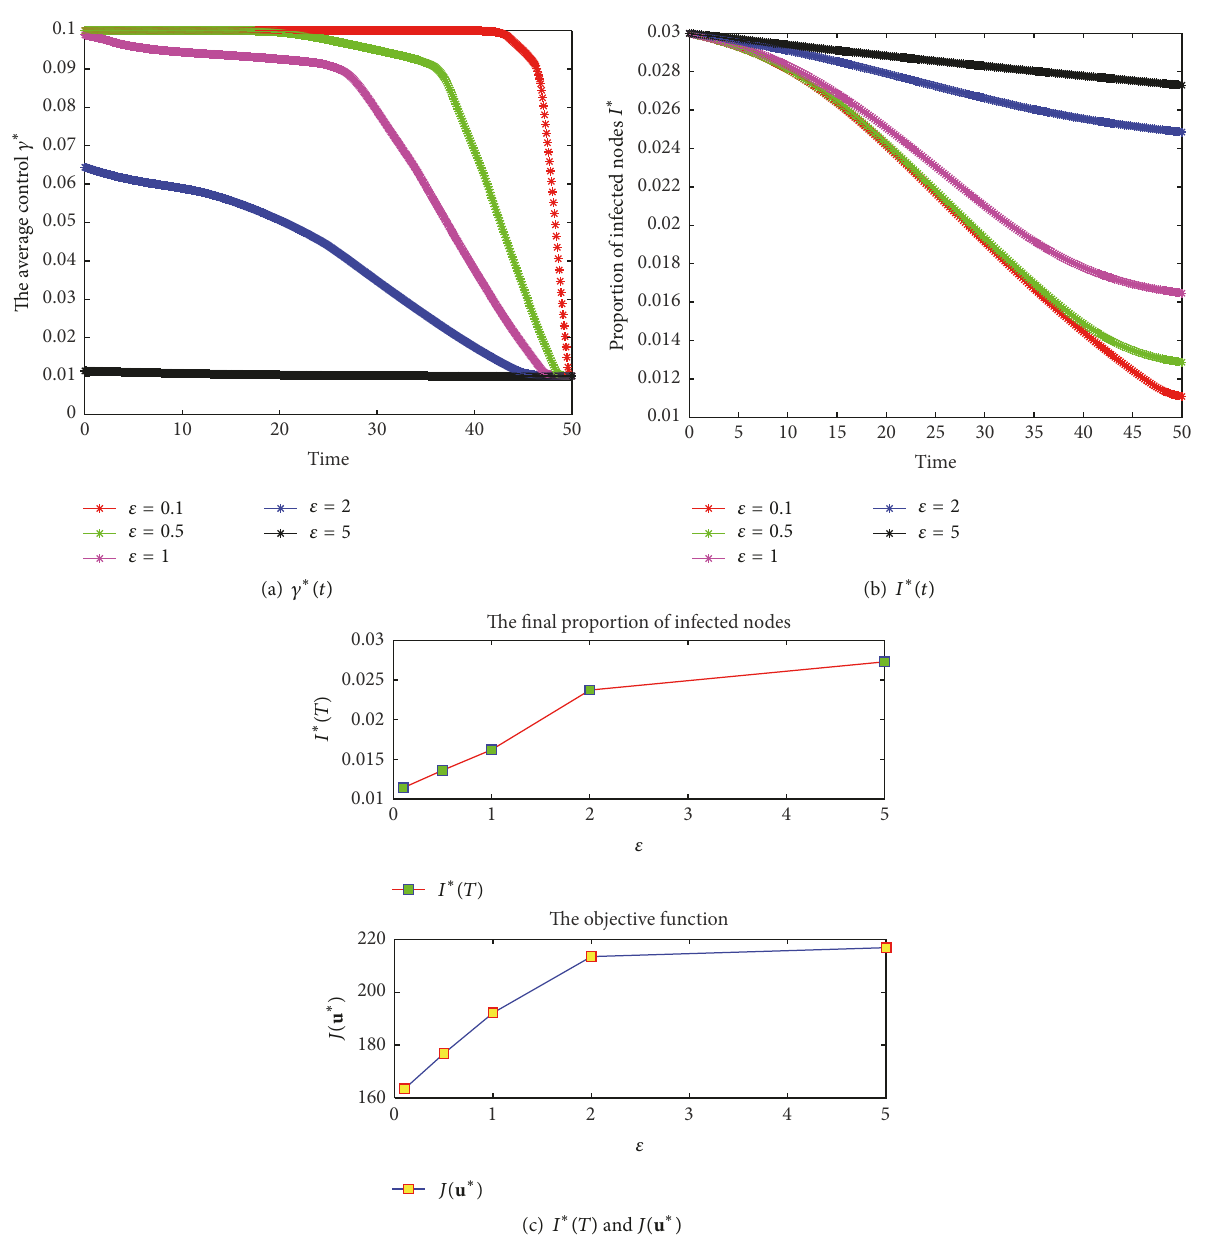
Figure 6: 𝛾 ∗ (𝑡) , 𝐼 ∗ (𝑡) , 𝐼 ∗ (𝑇) , and 𝐽( u ∗ ) for different 𝜀 with 𝑚 1 = 𝑚 2 = 5 for Example 1.